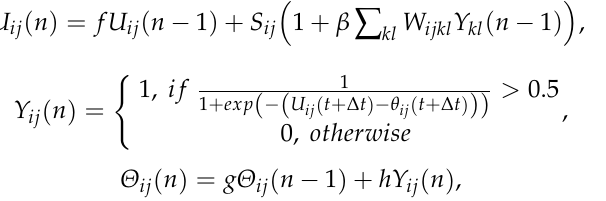
Figure 2. Image decomposition process of NSCT.